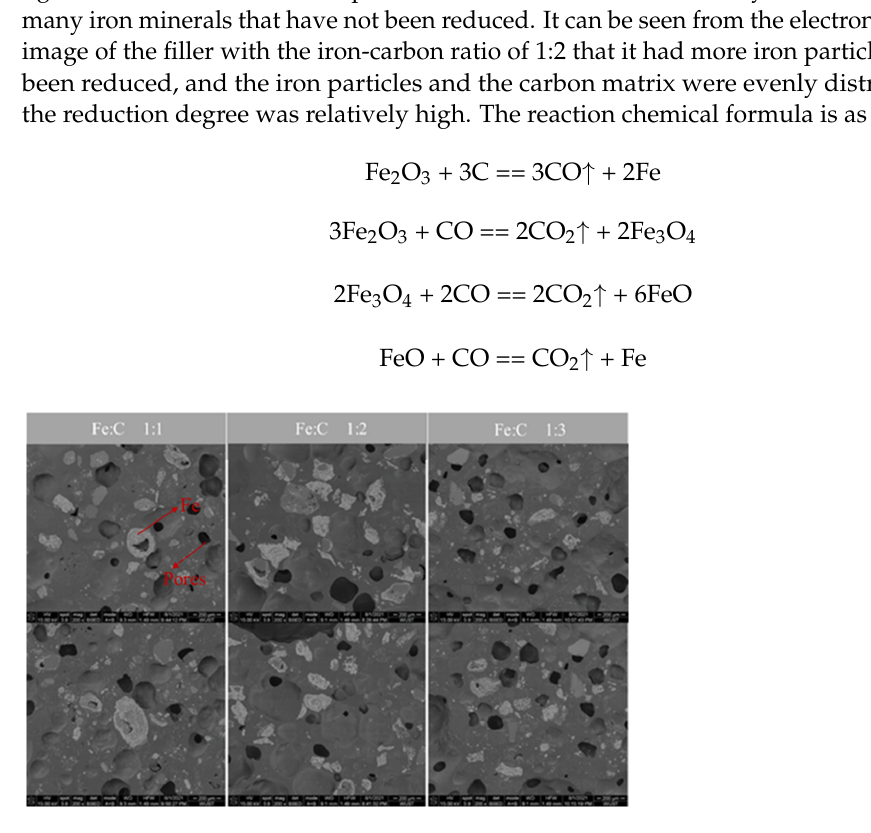
Figure 7. SEM images of iron-carbon micro-electrolytic fi llers with di ff erent ratios.